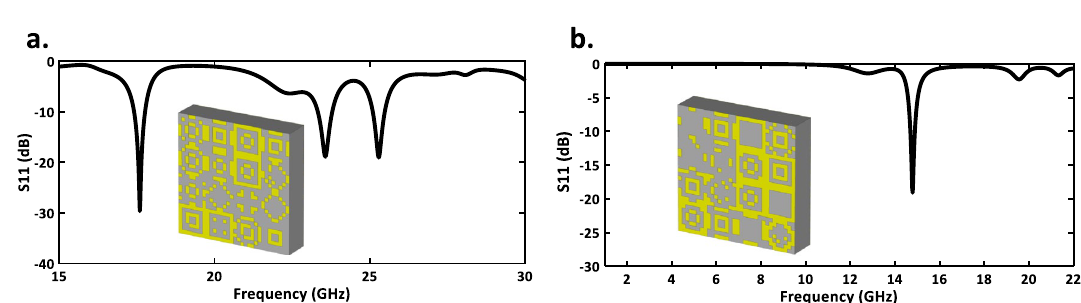
Figure 3. The simulated reflection coefficient of non-restricted output network architecture ( a ) metasurface with three notches under − 10 dB. ( b ) metasurface with a single notch under − 10